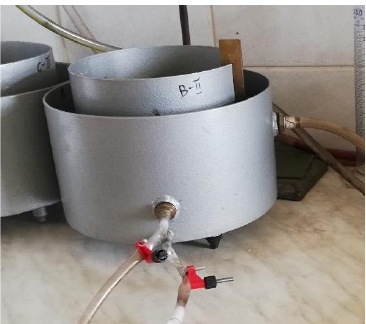
Figure 4. General view of the ITB-ZW-K2 apparatus for the filtration coefficient measurement (A. Gruchot).